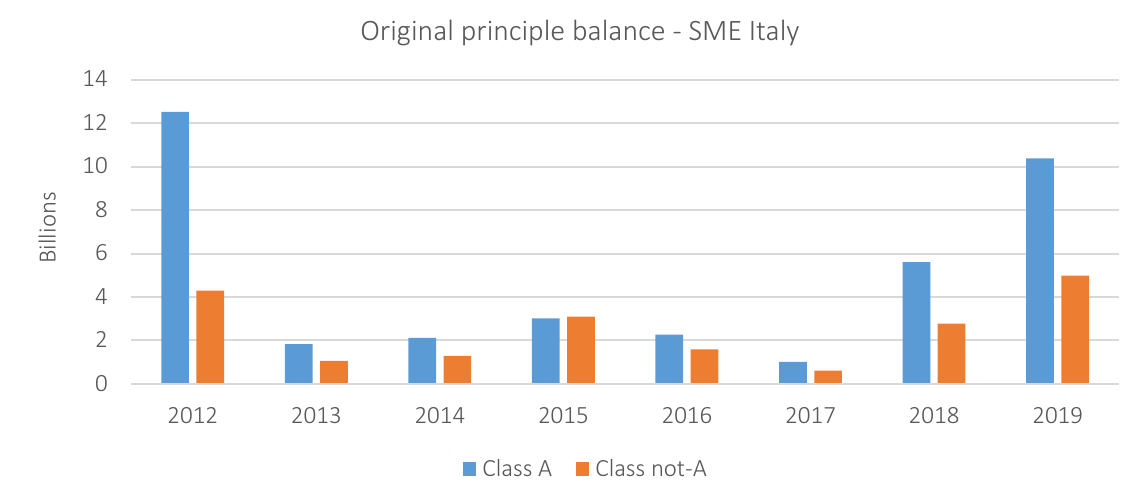
Figure A1. Original balance of securitized loans to Italian SMEs (Euros)